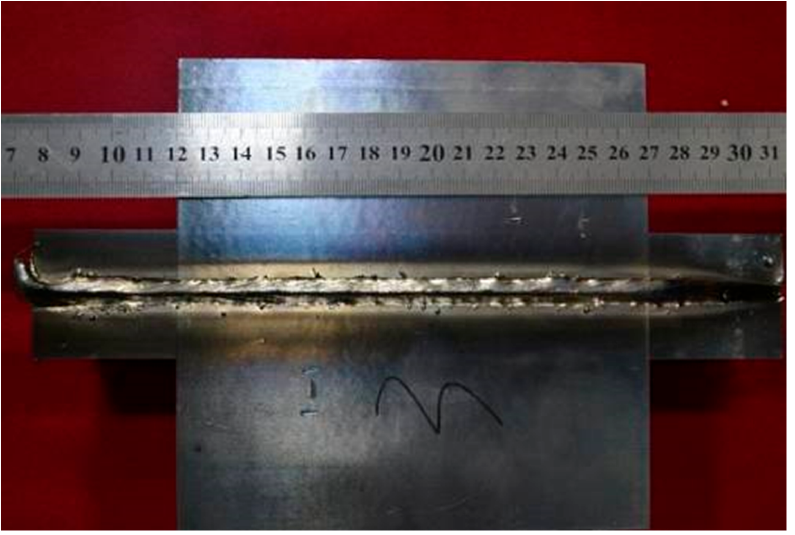
Figure 2. Electron beam welding of 32 mm ‐ thick Ti ‐ 6Al ‐ 4V plate.